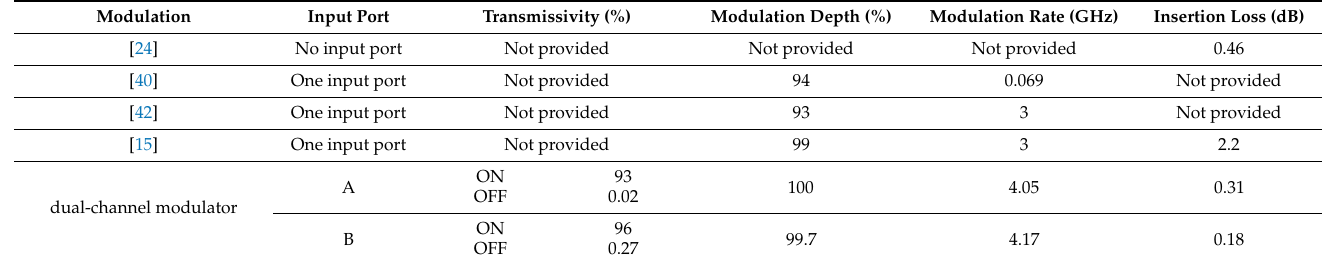
Table 2. Performance comparison.